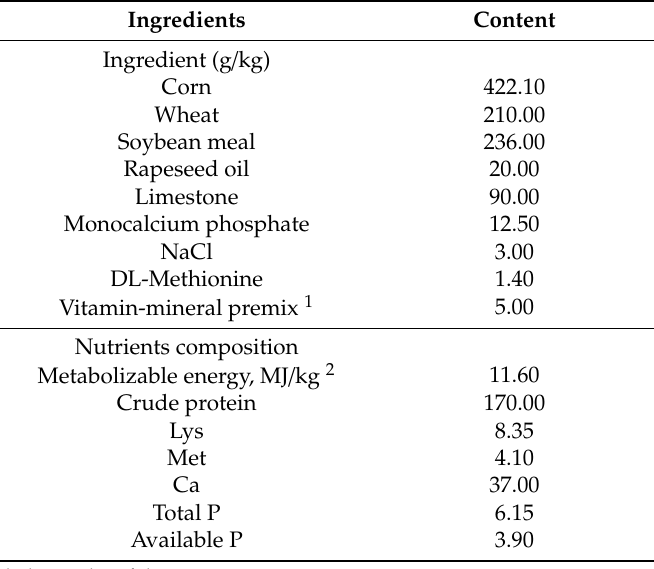
Table 1. Composition and nutrient content of experimental diet, g / kg air-dry